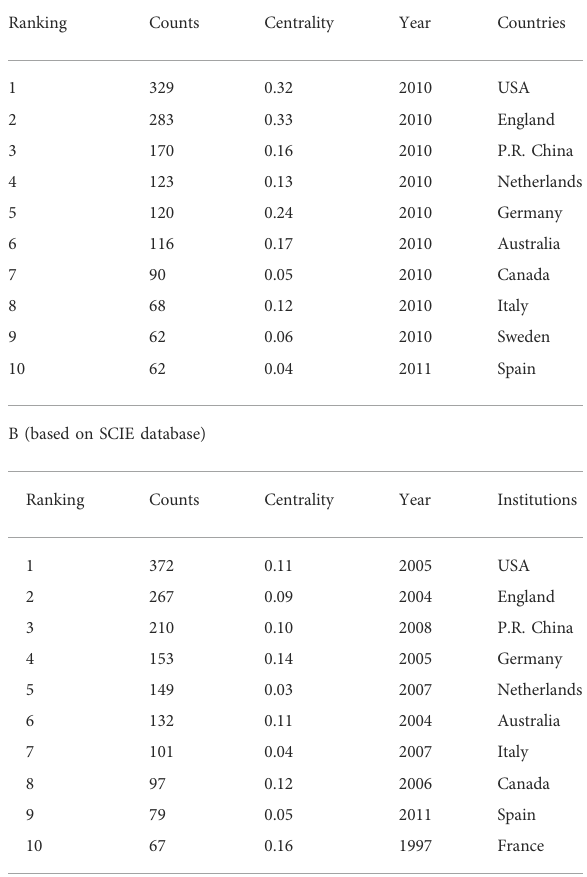
TABLE 3 Top 10 most productive countries in climate innovation